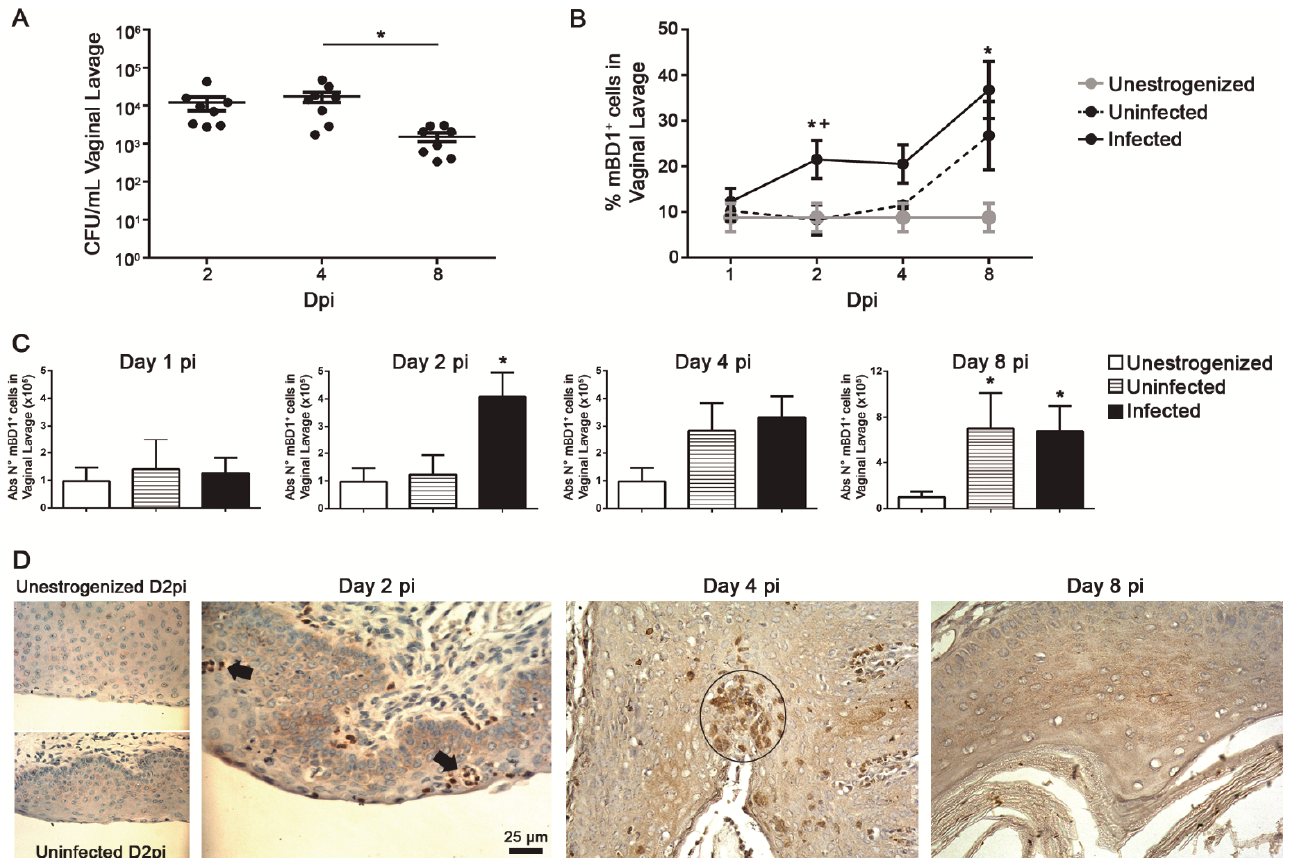
Figure 1. Upregulated expression of mBD1 in vaginal tract during VVC. ( A ) Fungal growth (CFU ± SEM) at D2, 4, and 8 pi in vaginal lavage of C57BL/6 mice infected i.v. with 5 × 10 6 cells of C. albicans ATCC 36801. Each point represents an individual mouse ( n = 8). Data are representative of three independent experiments. * p < 0.05. ( B ) Percentage of mBD1 total positive cells in vaginal lavage from C57BL/6 mice unestrogenized ( n = 7), uninfected ( n = 8), or infected ( n = 8) i.v. with 5 × 10 6 cells of C. albicans ATCC 36801 at different Dpi. Mean ± SEM of two independent experiments. * p < 0.05 infected vs. unestrogenized group; + p < 0.05 infected vs. uninfected group. ( C ) Absolute number of mBD1 total positive cells in vaginal lavage from C57BL/6 mice unestrogenized, uninfected, or infected i.v. with 5 × 10 6 cells of C. albicans ATCC 36801 at different Dpi. Mean ± SEM of two independent experiments. * p < 0.05 vs. unestrogenized group. ANOVA Test. ( D ) Vaginal tissue sections from C57BL/6 mice unestrogenized (D2), uninfected (D2), or infected i.v. with 5 × 10 6 cells of C. albicans ATCC 36801 at D2, 4, and 8 pi, stained with anti-mBD1 antibody. Positive cells stained brown with diamino- benzidine against the blue hematoxylin counterstaining. Images are shown at ×400 magnification. The black arrow indi- cates infiltrating PMNs cells, and the circle indicates the presence of microabscesses.